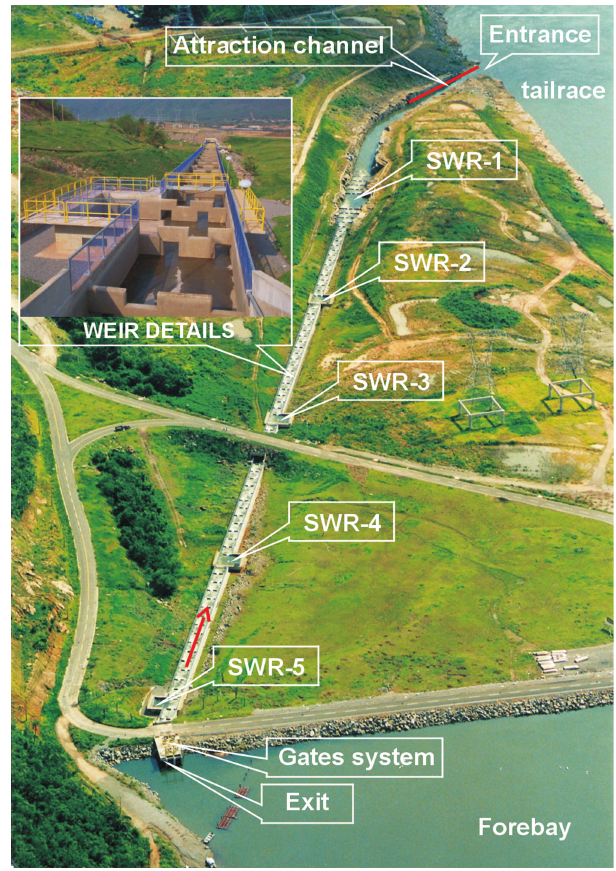
Fig. 1. Overview of the fish ladder and details of the weirs. SWR = Still Water